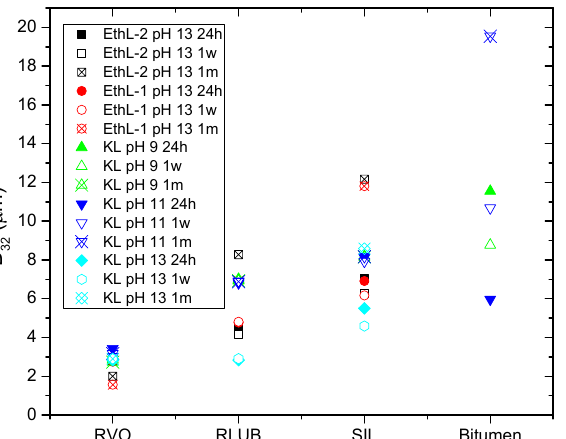
Figure 10. Evolution of emulsion droplet size with storage time as a function of the selected dis ‐ persed phase.